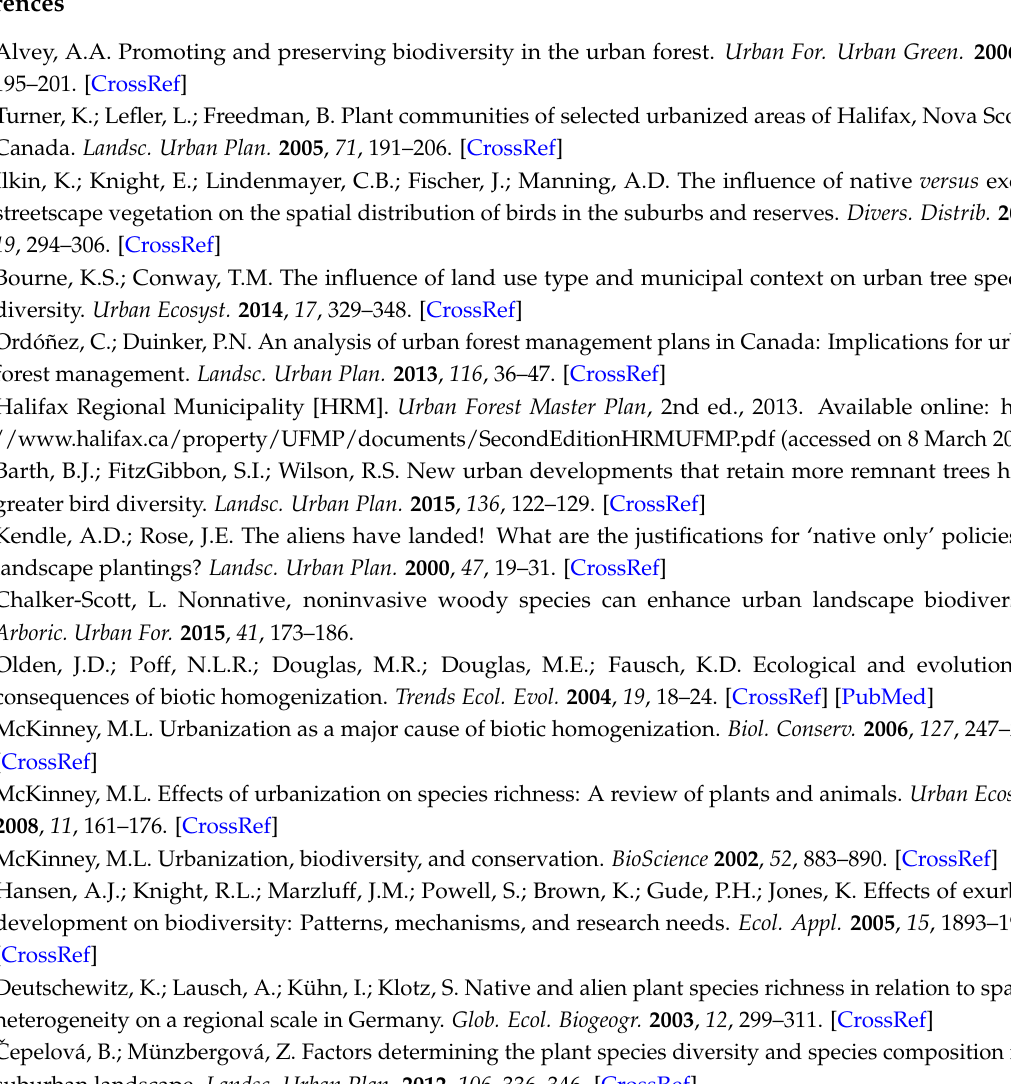
Figure A5. Correlation between private property lot size and number of species found on each lot ( R 2 = 0.17, p < 0.05, 284 lots sampled in total).